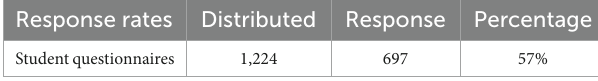
TABLE 5 Response rate of student questionnaires.